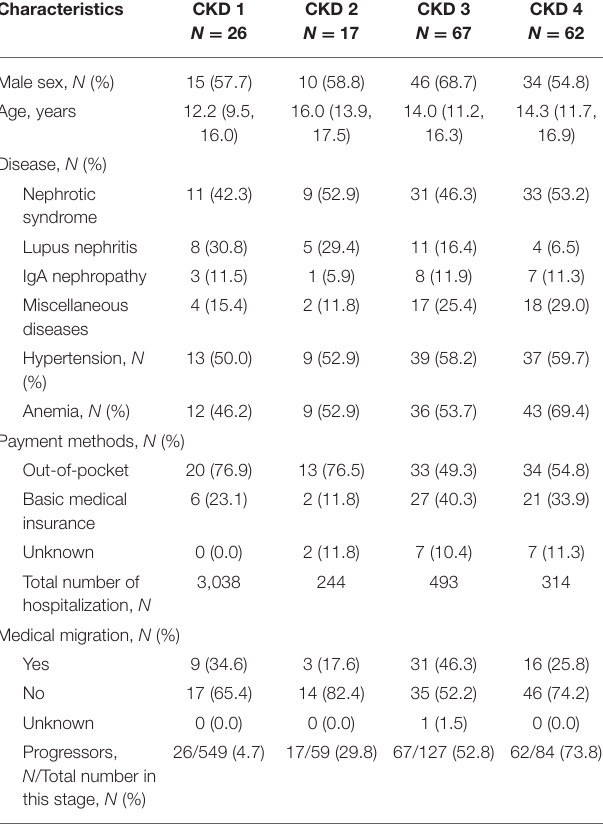
TABLE 2 | Baseline characteristics of 172 patients in progress group classified by CKD stages.